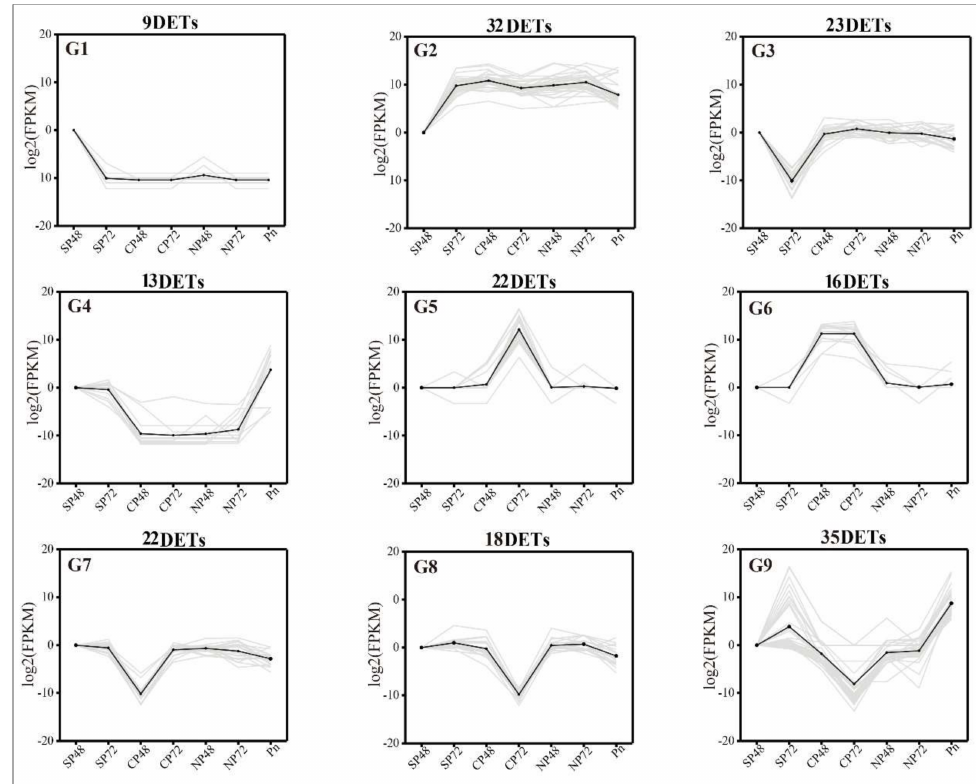
Figure 8. Trend analysis of di ff erentially expressed genes showing the transcriptome expression profiles. Nine clusters were identified. SP48 / 72, self-pollinated pistils at 48 h / 72 h; CP48 / 72, cross-pollinated pistils at 48 h / 72 h; NP48 / 72, non-pollinated pistils at 48 h / 72 h and Pn, mature pollen. FPKM = fragments per kilobase per million mapped